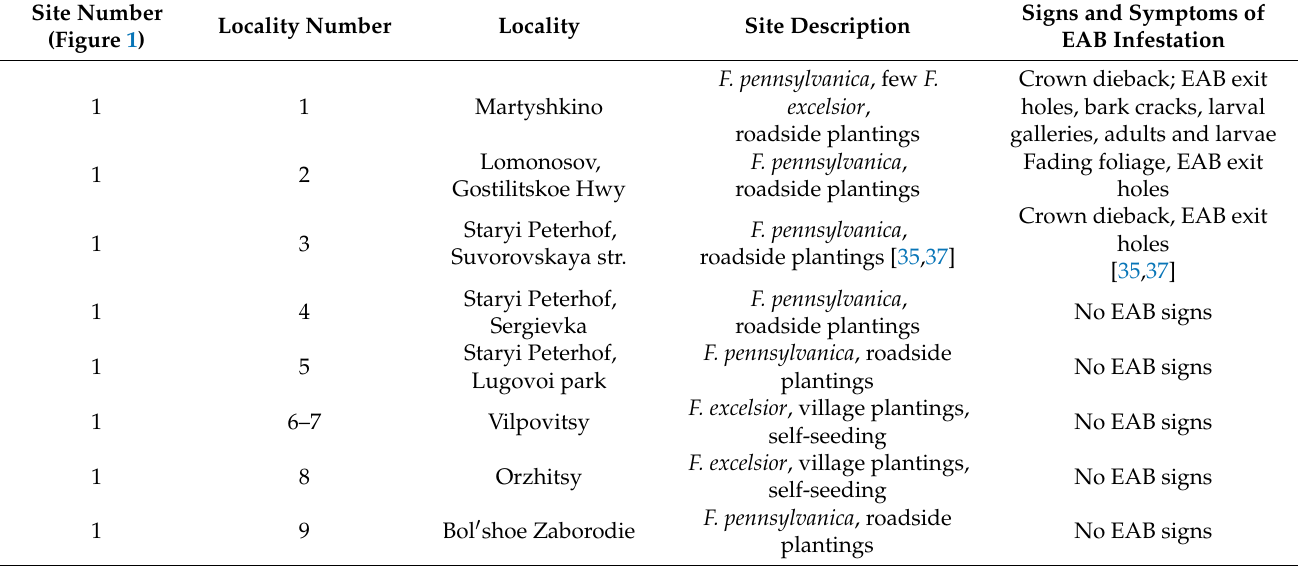
Table 1. Results of the survey of ash trees in St. Petersburg City and Leningrad Province (1), Moscow Province (2) and along the Volga River (3–11) in